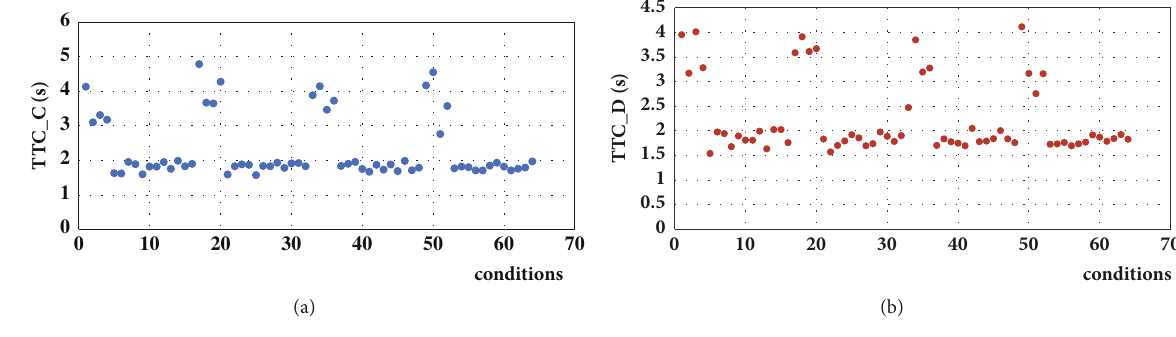
Figure 6: TTC in lane. (a) Lane C. (b) Lane